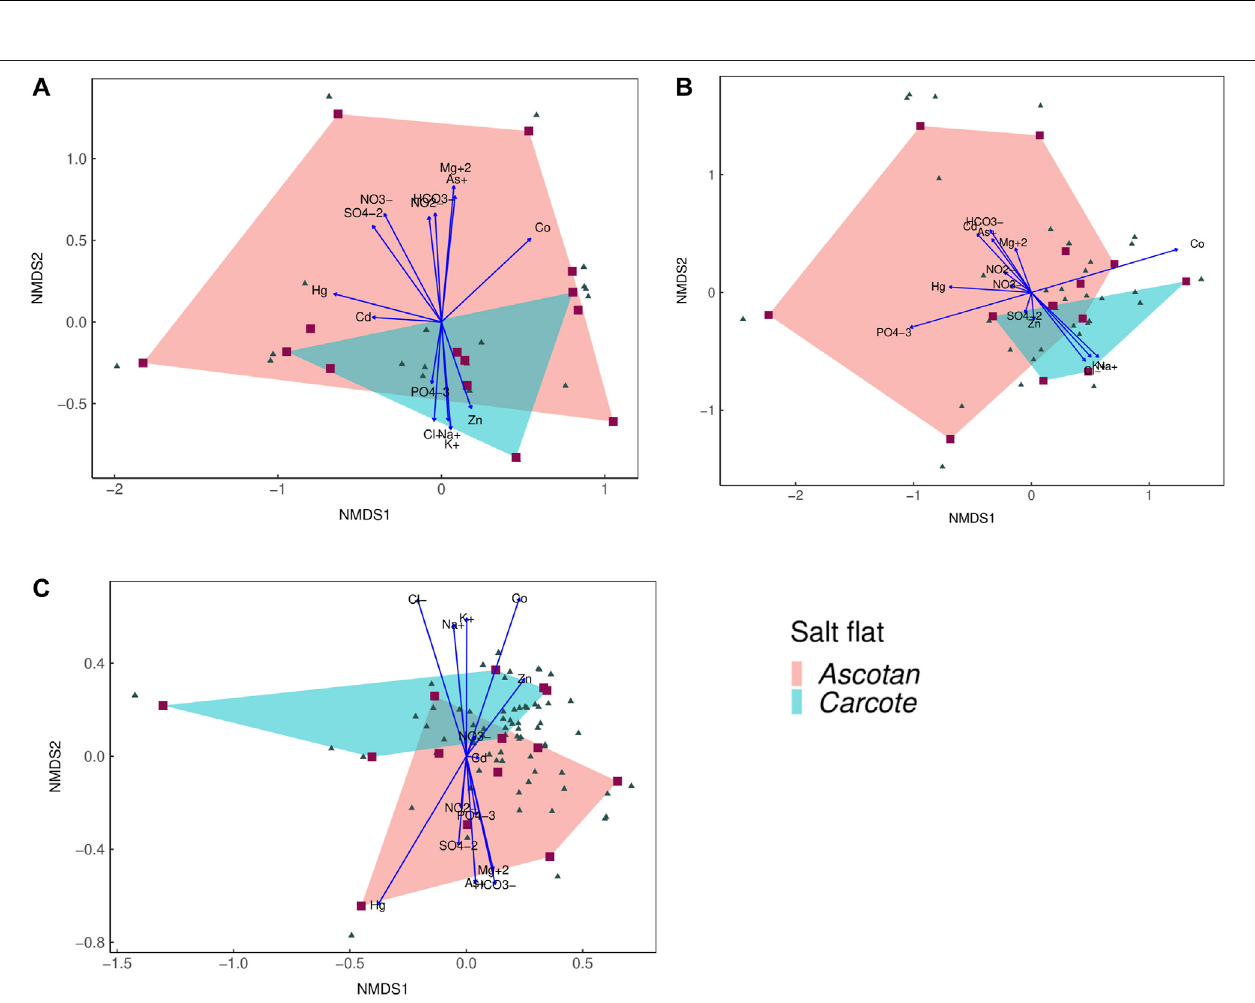
FIGURE 3 | NMDS analysis with environment ionic water column concentration for (A) high-pro fi le, (B) low-pro fi le, and (C) motile guilds; polygons represent the Ascotán (red) and Carcote (blue) salt fl ats.